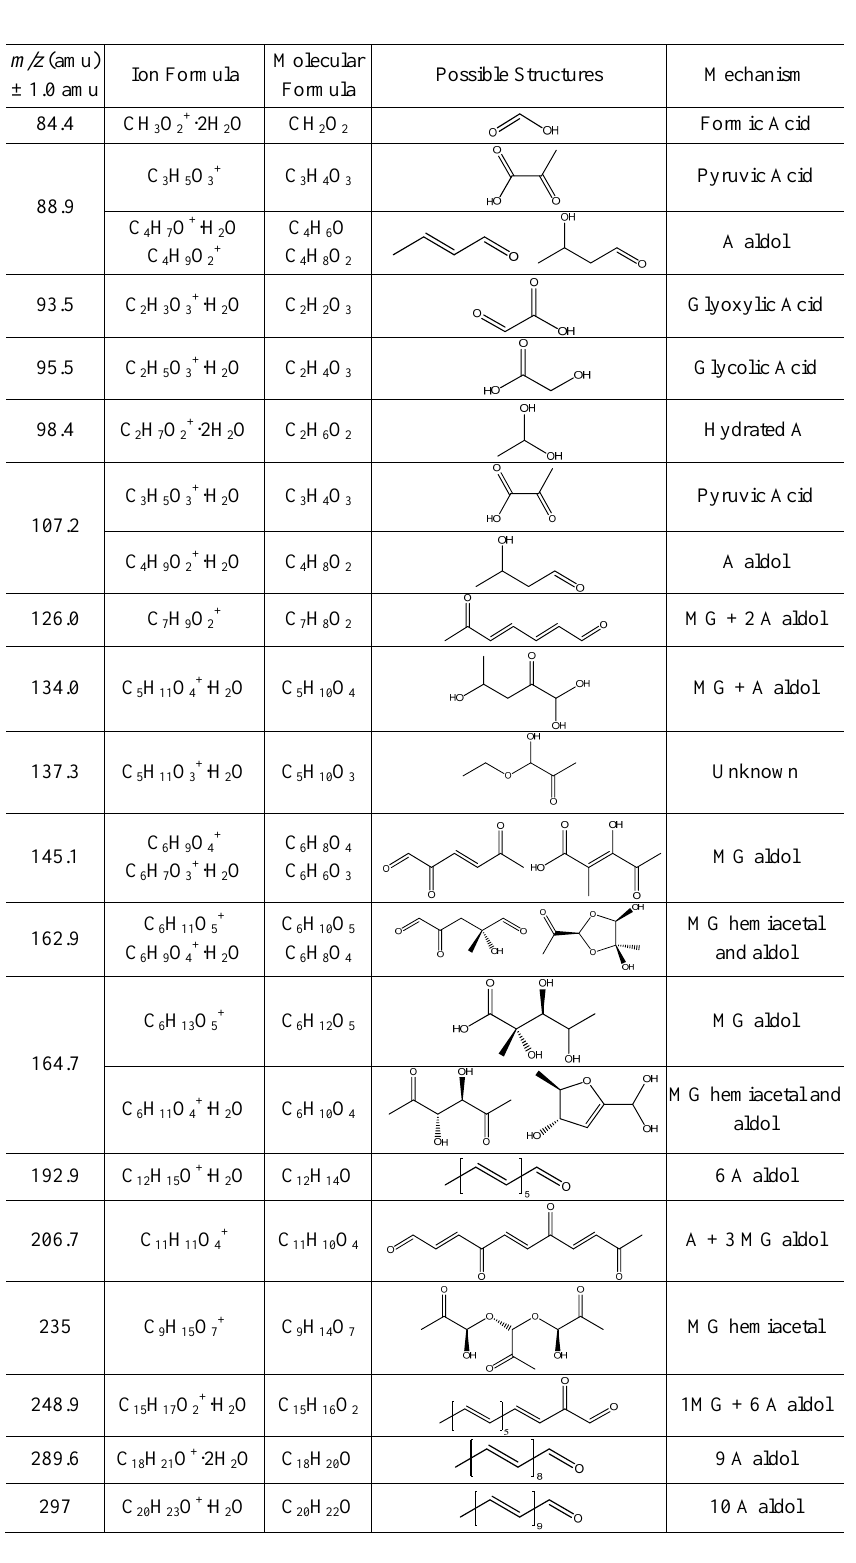
Table 4. Proposed peak assignments for Aerosol-CIMS mass spectra with H 3 O + of atomized solutions of 0.5M acetaldehyde/MG (1:1) in